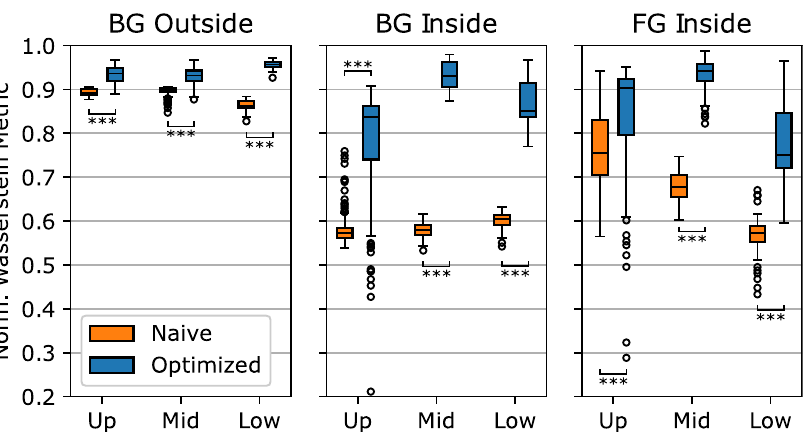
Fig 4. Normalized Wasserstein metric between intensity distributions of real and naive (orange bars, Naive) and real and optimized data (blue bars, Optimized). The measure is calculated for three image regions: background outside and inside the spheroid, and foreground. The images are divided into an upper, middle and lower part. A value of one indicates a perfect result, while a value of zero indicates a bad result.